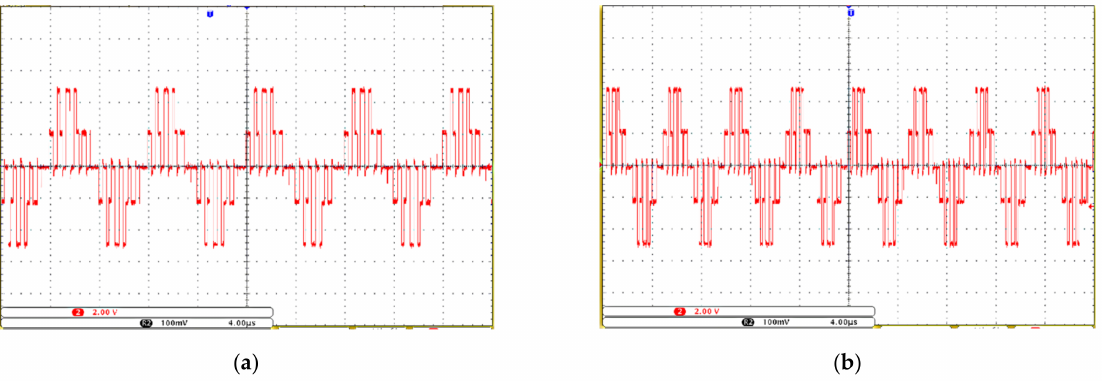
Figure 14. Comparison waveforms of line voltage by regulating frequency: ( a ) before regulating, ( b ) after regulating.